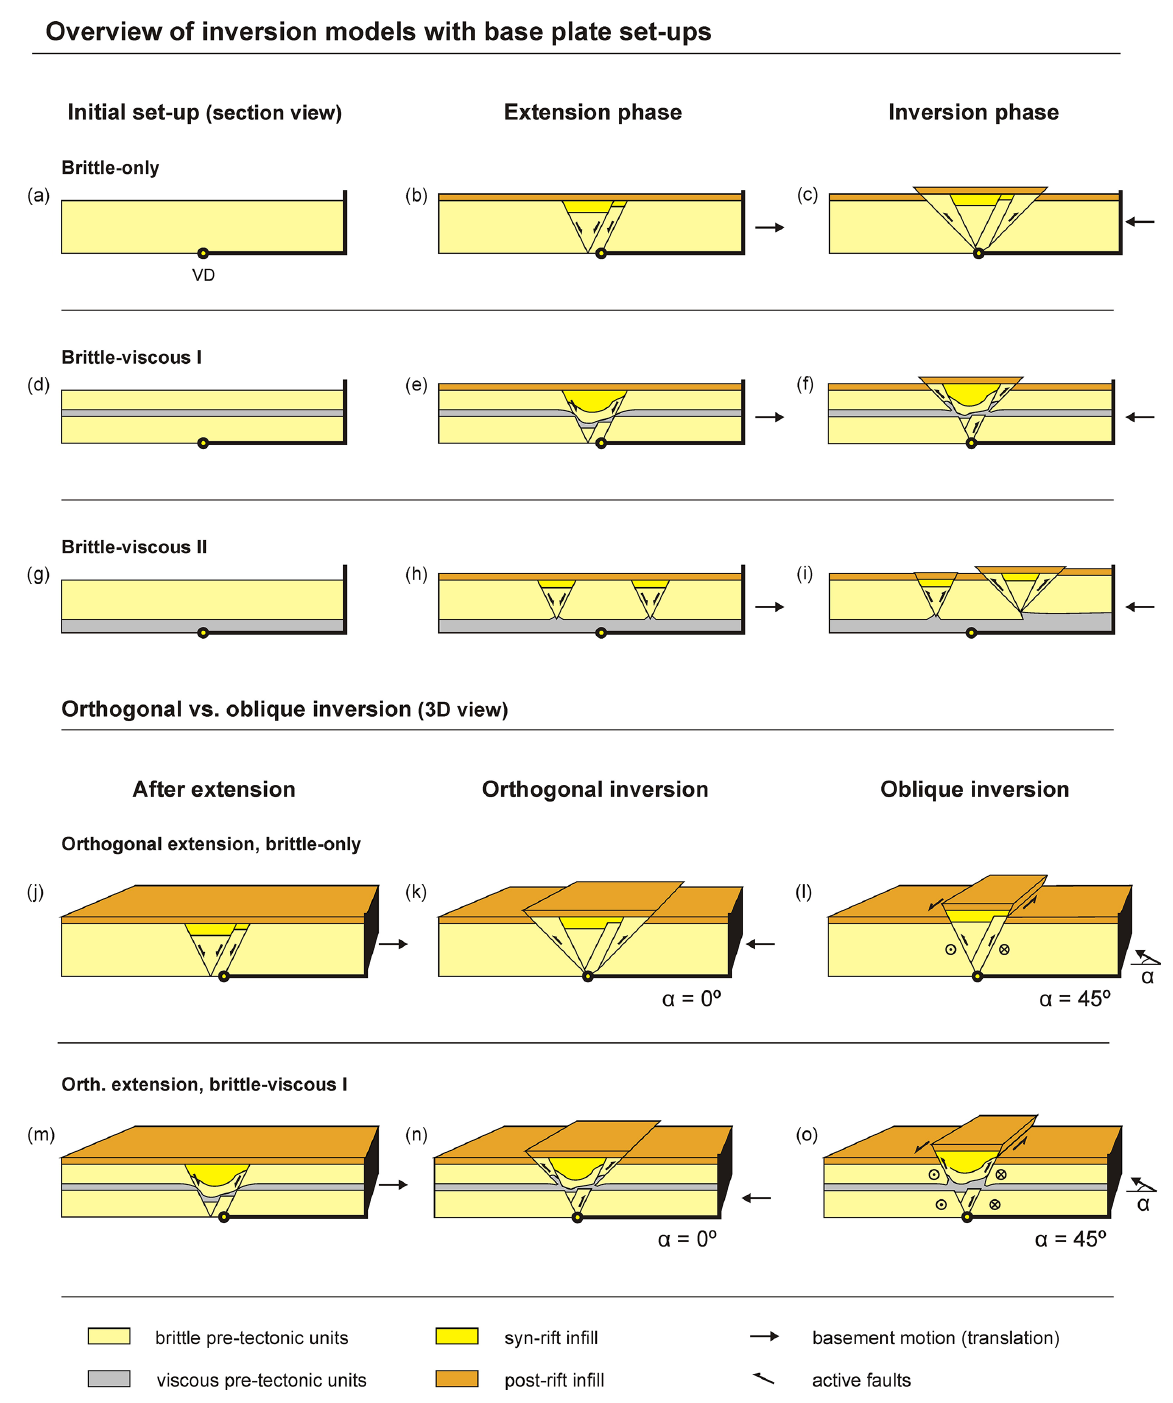
Figure 11. Sketches of representative results from basin inversion models involving a set-up with base plates. VD stands for velocity discontinuity. (a–c) Brittle-only inversion experiment. (d–f) Brittle–viscous set-up I with a viscous layer within the brittle layer. (g–i) Brittle– viscous set-up II with a viscous base layer. (j–o) The 3D effect of the inversion direction on reactivation of pre-existing faults. Oblique compression promotes oblique-slip reactivation of steep normal faults that are unlikely to be reactivated in an orthogonal compression situation. This effect is also observed in inversion models with a viscous basal detachment layer (Pinto et al., 2010; Muñoz-Sáez et al., 2014). Images inspired by Dubois et al. (2002), Nalpas et al. (1995), Brun and Nalpas (1996), and Mattioni et al. (2007).